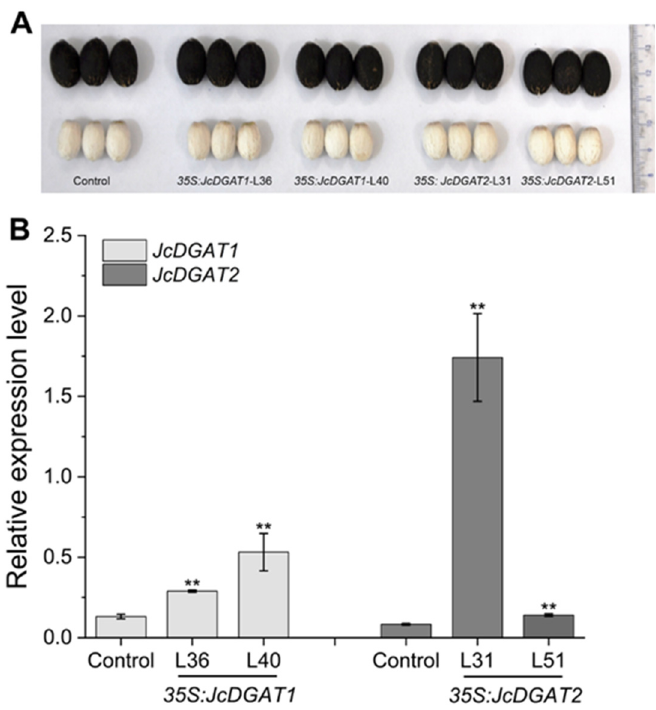
Figure 2. Appearance of seeds and kernels from 35S:JcDGATs transgenic J. curcas lines. (A) Pheno- types of seeds and kernels from control and transgenic lines. (B) The expression levels of JcDGAT1 and JcDGAT2 in the control and 35S:JcDGATs transgenic seed kernels. The expression levels were normalized using the amplified products of the JcActin1 . The values are presented as the mean ± standard deviations (n = 3). The student’s t-test was used for statistical analyses. ** p ≤ 0.01.